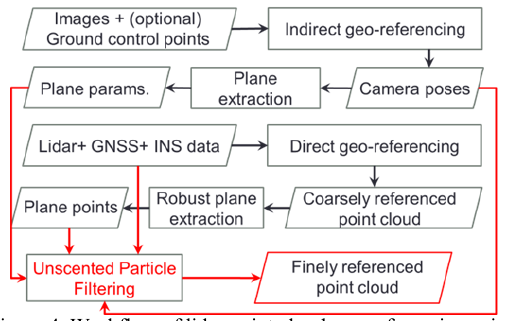
Figure 4. The general structure of the implemented UPF is as follows: